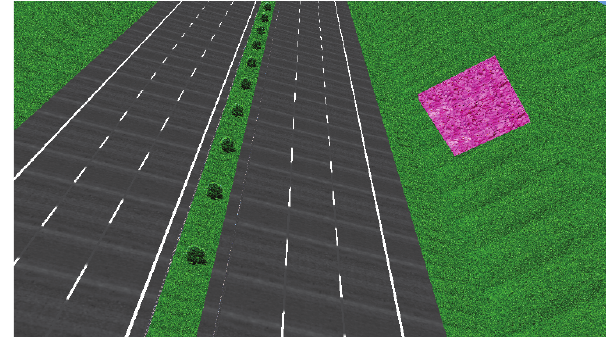
Figure 2: Color contrast on the conspicuity.